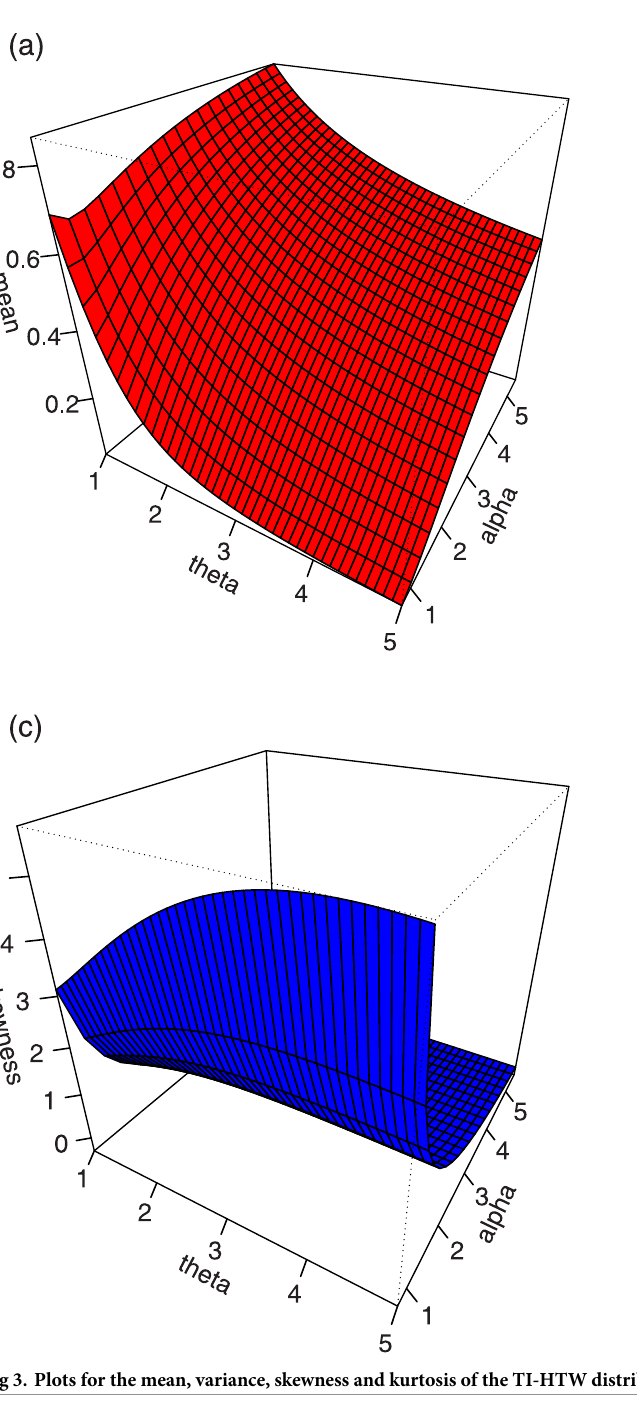
PLOS ONE | https://doi.org/10.1371/journal.pone.0237462 August 27,